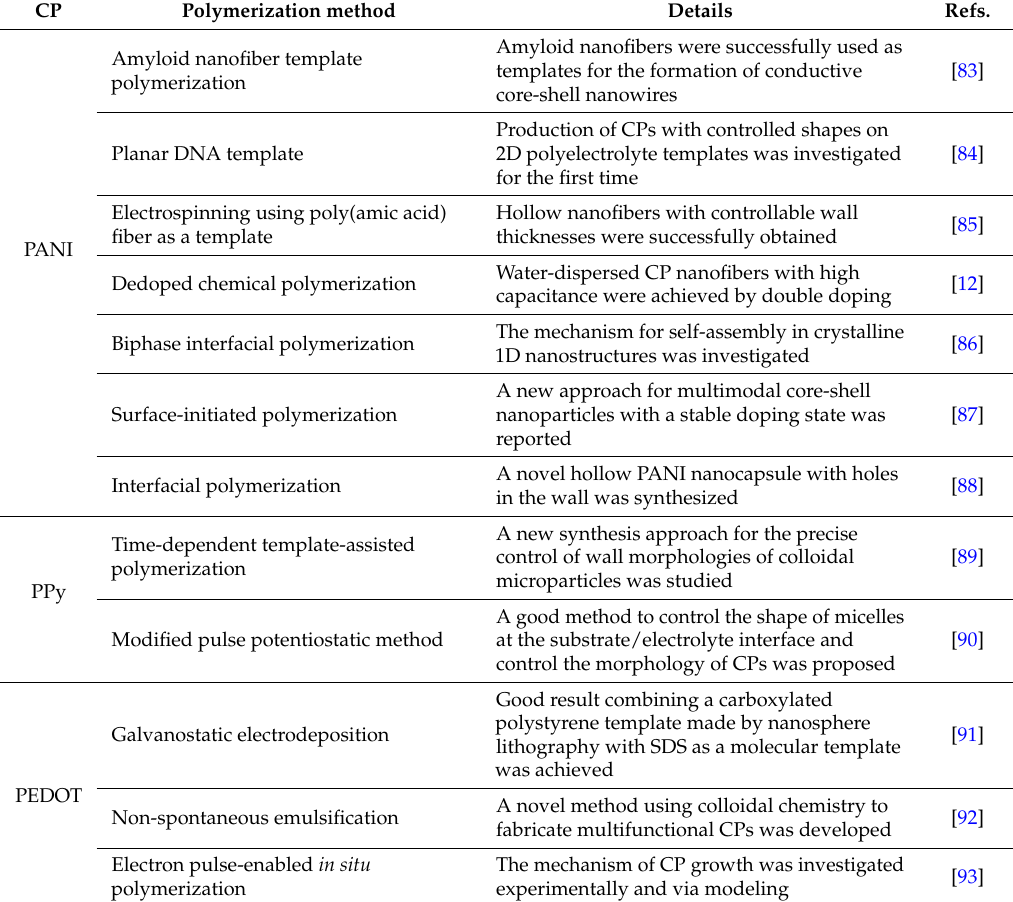
Table 4. Representative examples of fabrication methods for CP nanomaterials developed over the last three years.